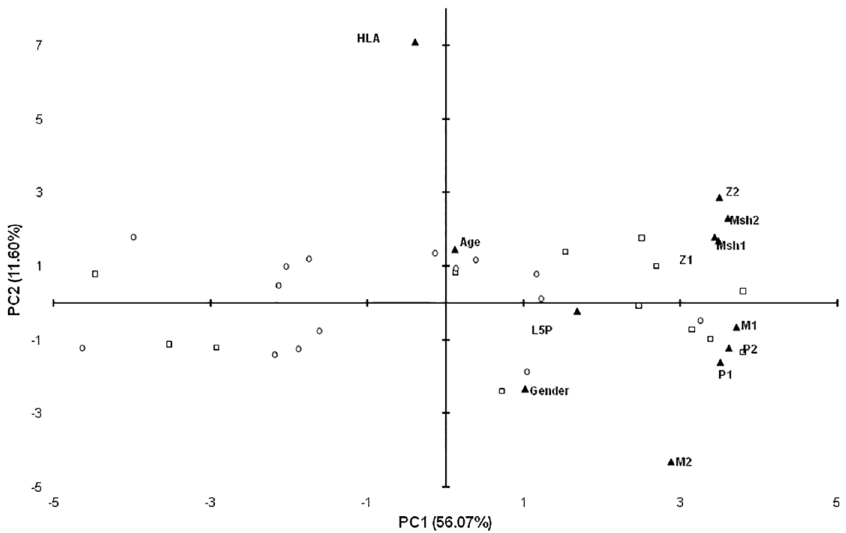
Fig 3. Principal component analysis of variables describing relationship with positivity to L5P in samples of children at risk for T1D. Bi-plot illustrates correlation between levels of anti-L5P Abs and variables relative to T1D genetic predisposition, available demographics data and titers of Abs against MAP- derived homologous peptides: MAP3865c 133 – 141 (Msh1); MAP3865c 125-133 (Msh2); MAP2404c 70-85 (M1); MAP1,4 α gbp 157-173 (M2); ZnT8 186-194 (Z1); ZnT8 178-186 (Z2); PI 64-80 (P1) and PI 46-61 (P2). Children reactive to L5P antigen are indicated by squares whereas circles correspond to negative samples. All variables are described by labels and their position on the plot is indicated by triangles. The distribution shows relationship between PC1 and PC2 explaining 67.67% of the total variation. Only samples of children with known HLA genotype are